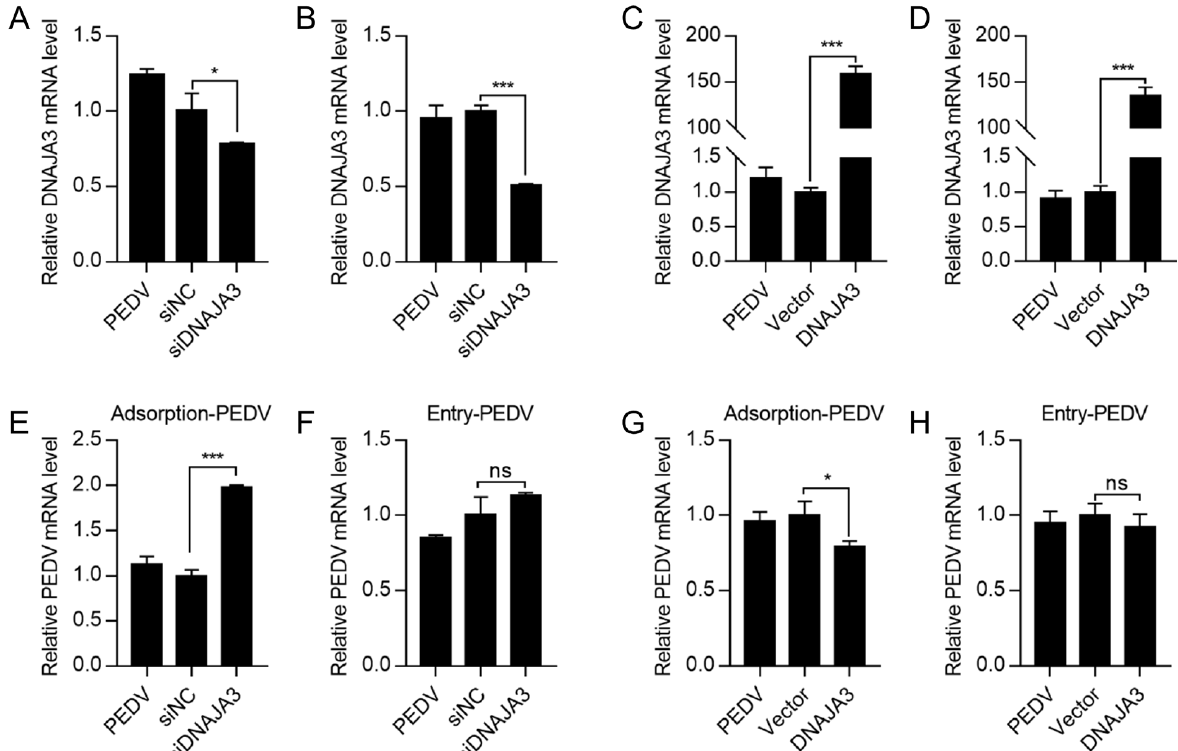
Figure 6. Effects of DNAJA3 on adsorption or internalization of PEDV. ( A – D ): IPEC-J2 cells trans- fected with gene silencing vector siDNAJA3 (with siNC as control) or with expression vector pCMV-DNAJA3 (DNAJA3) (with pCMV-Flag as Vector control) for 24 h and the transfected cells were then inoculated with PEDV (5.0 MOI) for 1 h at 4 °C to allow virus attachment without internalization. The cells in wells for adsorption were then washed and used to extract total RNA to detect mRNA levels of DNAJA3 ( A , C ). The cells in the remaining wells were cultured in fresh serum-free DMEM and subsequently shifted to 37 °C to allow virus internalization for 1 h. The cells were washed to remove non-internalized virions and used to total RNA of infected cells to detect mRNA levels of DNAJA3 ( B – D ). ( E , F ): Effects of DNAJA3 knockdown on PEDV adsorption and internalization shown as viral RNA copies. ( G , H ): Effects of DNAJA3 overexpression on PEDV adsorption and internalization shown as viral RNA copies. For all RT-qPCR analysis, the transcription levels of control vectors (siNC or Vector) were set to 100%. The results are presented as the mean ± SD of data from three independent experimen ts. ns, p > 0.05; *, p < 0.05; ***, p < 0.001.